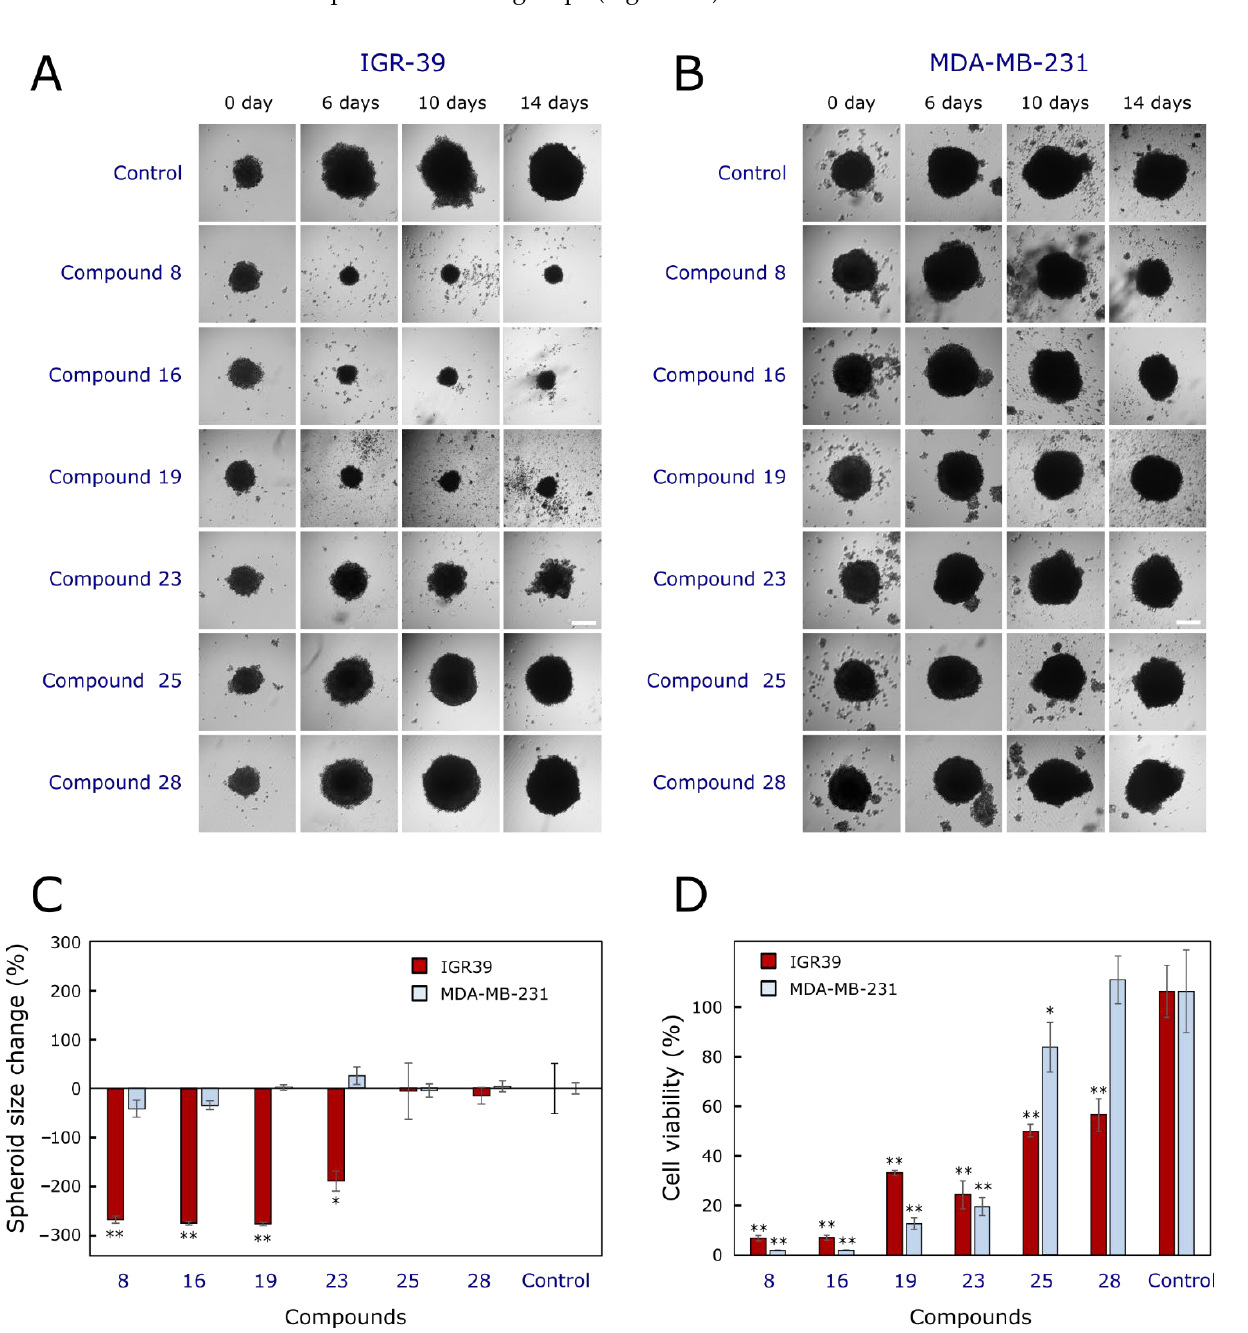
Figure 5. Effect of compounds on 3D cell cultures. ( A ) Photos of human melanoma IGR39 tumor spheroids at different periods of experiment. ( B ) Photos of human triple-negative breast cancer MDA-MB-231 tumor spheroids at different periods of experiment. ( C ) Spheroid size at the end of experiment. ( D ) Cell viability in MDA-MB-231 and IGR39 spheroids. Asterisks (*) indicate p < 0.05 and (**) indicate p < 0.01 compared to the control (untreated spheroids). Scale bars indicated 200 µm. Each group contained 8–10 spheroids. Data are presented as means ± standard deviations.